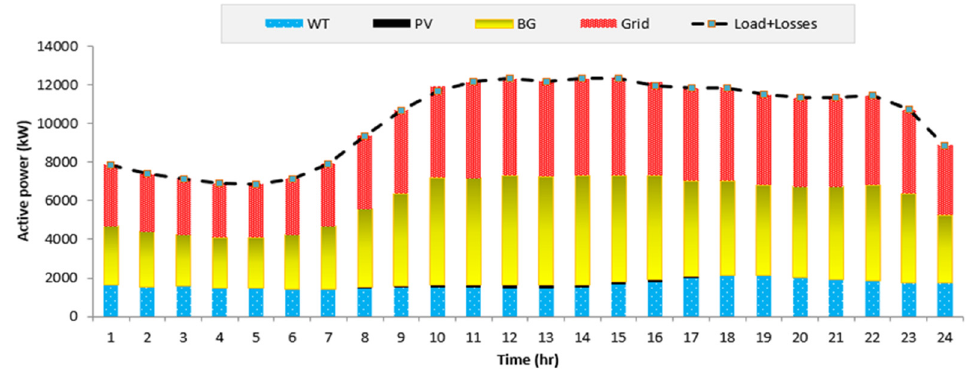
Figure 20. Results of the optimal operation for the second MG.